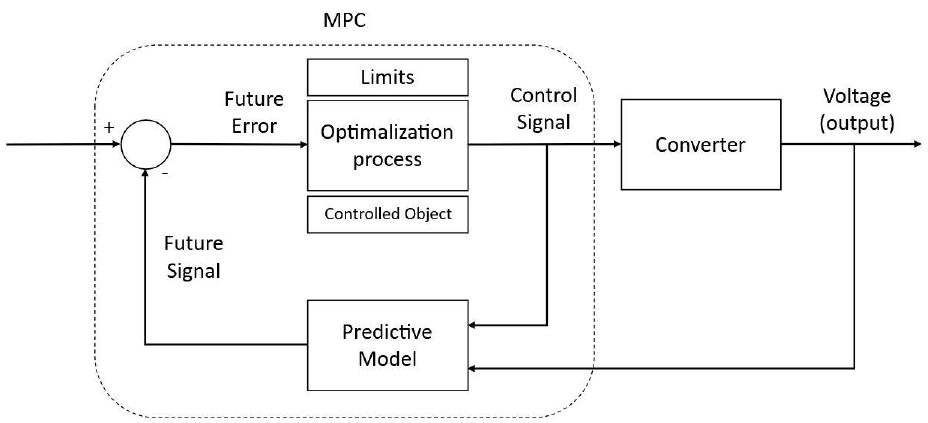
Figure 6. The model-based predictive control (MPC) converter control loop